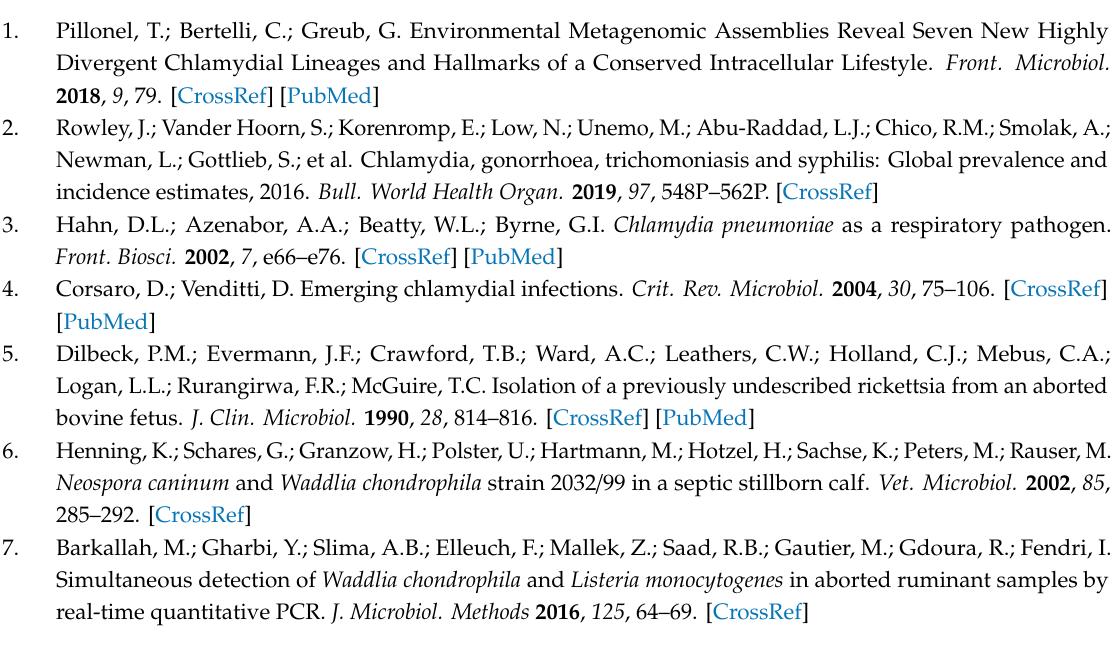
Figure S1. Viability of HEp-2 cells in presence of 2,2 (cid:48) -bipyridyl. Figure S2. Infection rate obtained with di ff erent dilutions of the W. chondrophila inoculum. Figure S3. Aberrant bodies formation in the presence of BPDL depends on the concentration and time of addition of BPDL. Figure S4. Rarefaction analysis on the RNA sequencing samples. Figure S5. Gene expression in BPDL-treated W. chondrophila versus untreated RBs. Figure S6. Normalized expression profile of the top down-regulated genes in response to iron deprivation. Figure S7. Normalized expression profile of the top up-regulated genes in response to iron deprivation. Table S1. (xlsx file). RNA-seq data. Table S2. (xlsx file). Gene ontology enrichment analysis of down-regulated genes. Table S3. (xlsx file). Gene ontology enrichment analysis of up-regulated